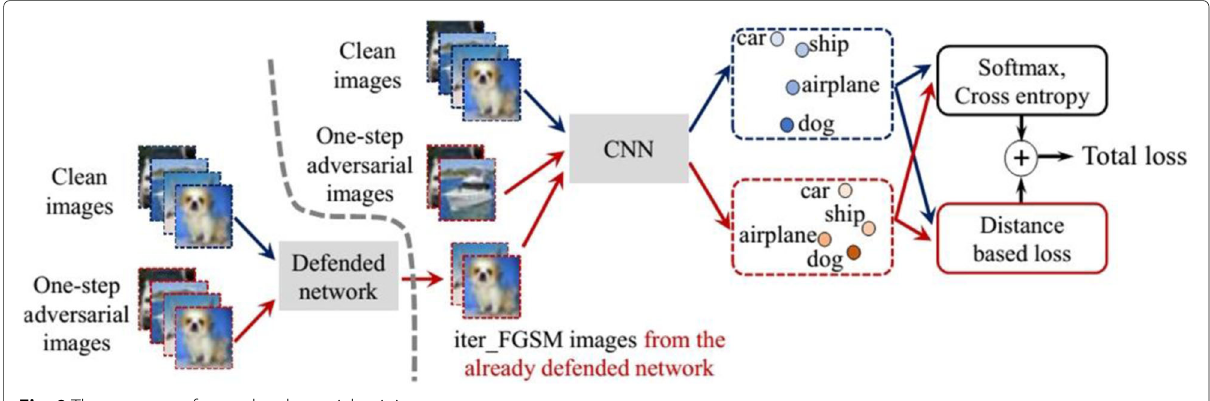
Fig. 9 The structure of cascade adversarial training